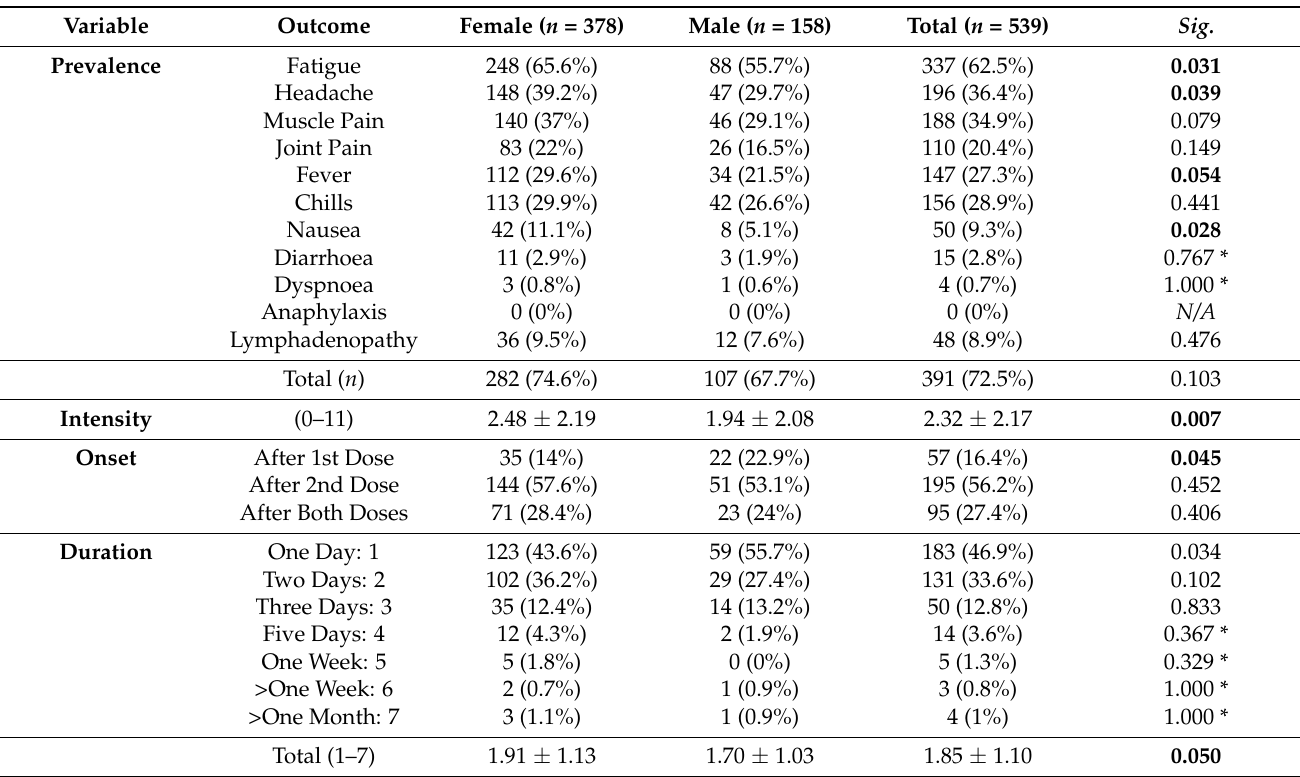
Table 4. Systemic side effects of young adults (18–30 years old) receiving mRNA-based COVID-19 vaccines, Czech Republic, April–June 2021 ( n =